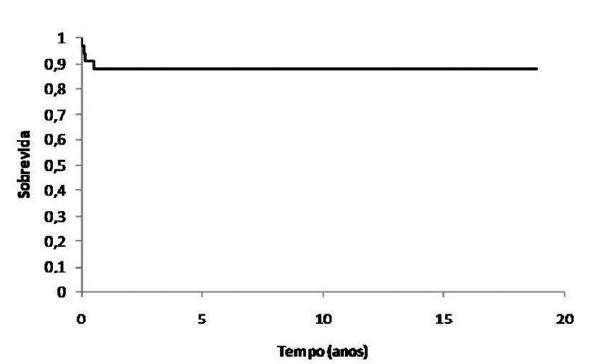
Fig.1 - Probabilidade de sobrevida com até 20 anos de seguimento clínico (média de 9,6±8,4 anos). Método de Kaplan Meier.